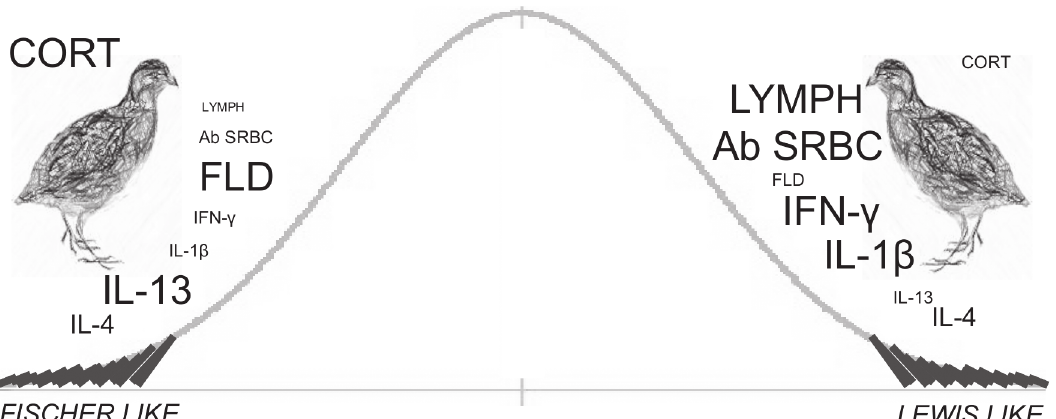
Fig 5. Schematic conceptual representation of INPs in Coturnix coturnix . The variables set to determine the existence of avian INPs in the present study are represented around each bird. The size of the variable indicates if the animals show high or low response in each of the parameters in the INPs. LYMPH: lymphoproliferative response to PHA-P; Ab SRBC: antibody response against SRBC; FLD: frequency of leukocyte distribution; level of expression of mediators: IFN- γ and IL-1 β (pro-inflammatory); and IL-4 and 13 (anti-inflammatory). "Fischer-like" quail with high CORT levels also manifest high FLD and IL- 13, but low LYMPH, Ab SRBC, IFN- γ and IL-1 β levels. "Lewis-like" counterparts have low CORT as well as low FLD and IL-13 responses, but high LYMPH, Ab SRBC, IFN- γ and IL-1 β responses. These two extreme groups of birds do not differ in their IL-4